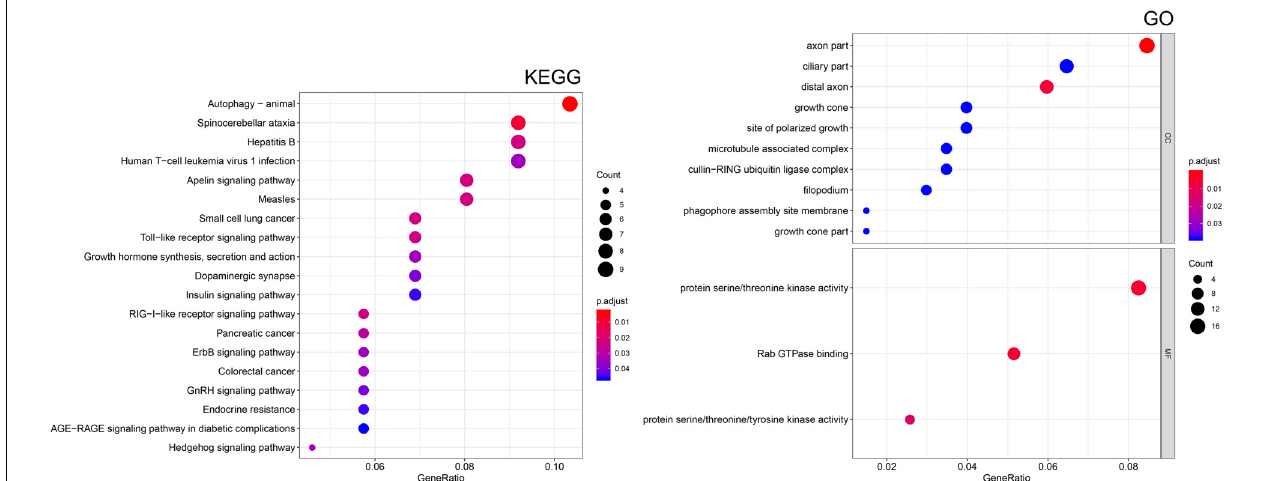
FIGURE 7 | Functional enrichment analysis of target mRNAs. Kyoto Encyclopedia of Genes and Genomes (KEGG) pathway enrichment analysis of mRNAs. Gene ontology (GO) enrichment analysis of the mRNAs. CC, cellular component; MF, molecular function.